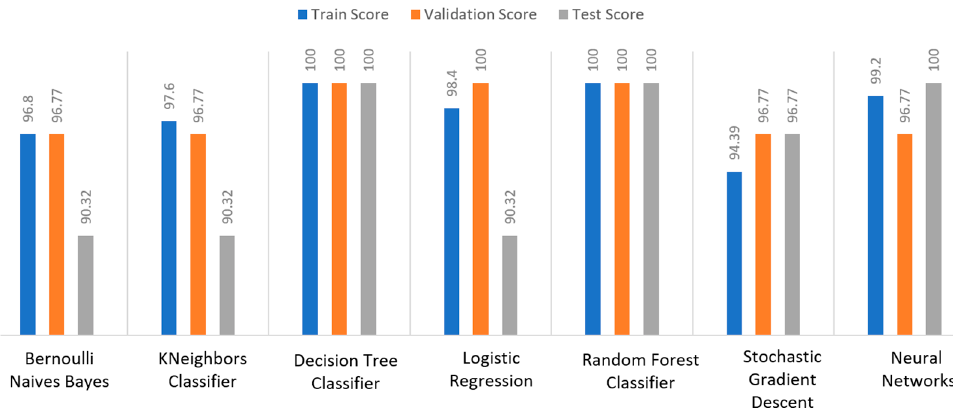
Figure 30. Train–validation–test score for kidney disease use case.